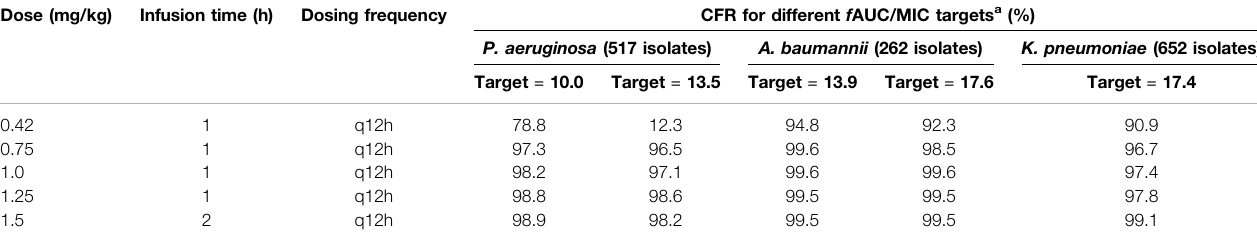
TABLE 2 | Cumulative fraction of response ( CFR) to different dosing regimens of polymyxin B against P. aeruginosa, A. baumannii and K. pneumoniae . Dose (mg/kg) Infusion time (h) Dosing frequency